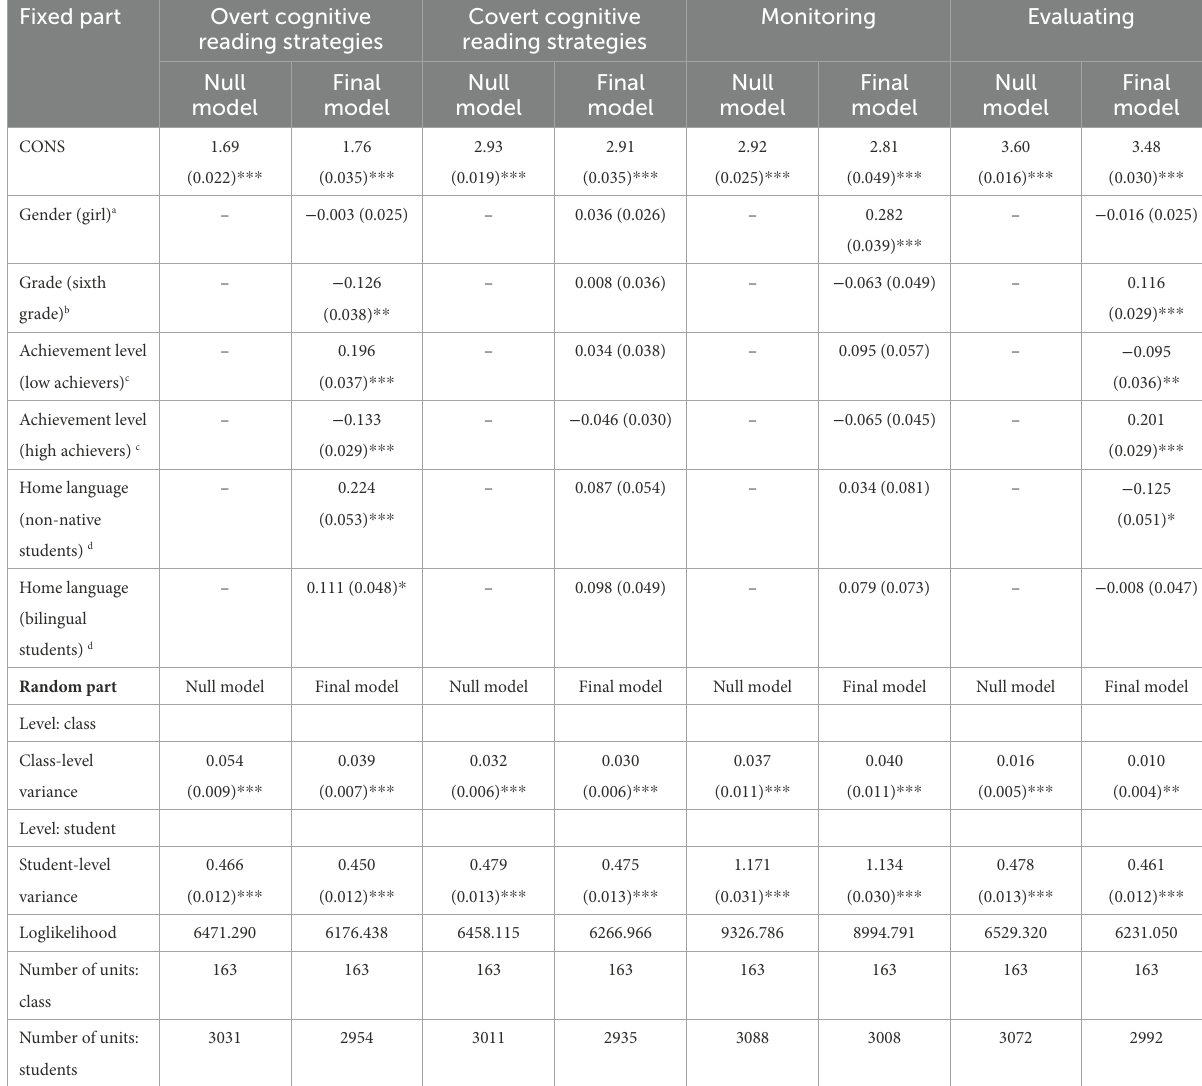
TABLE 5 Summary of the model